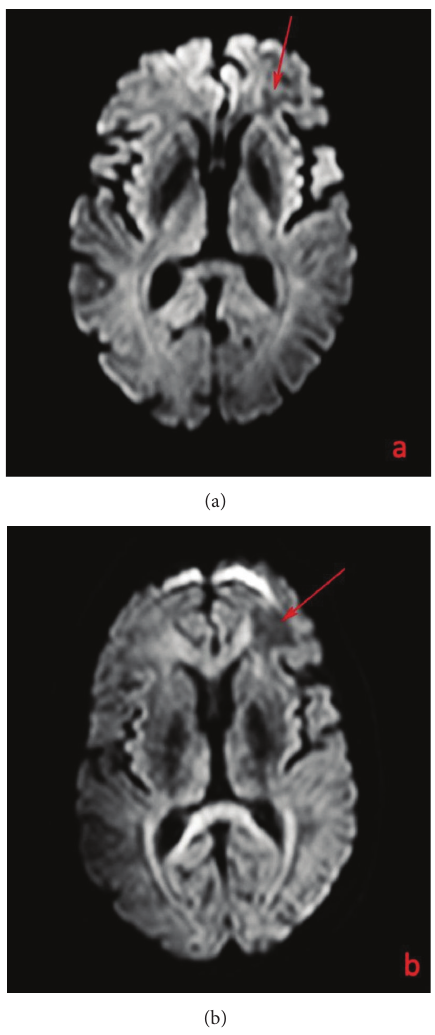
Figure 3: DWI ADC map (Philips Achieva 3T, TR = 4500ms; TE = 112ms) in December 2011 (a) and May 2012 (b) of the white matter lesion underneath the frontal lobe of the left hemisphere (arrows) with some diffusion restriction in a 44-year-old man with a 12-year history of MS affected by natalizumab-related